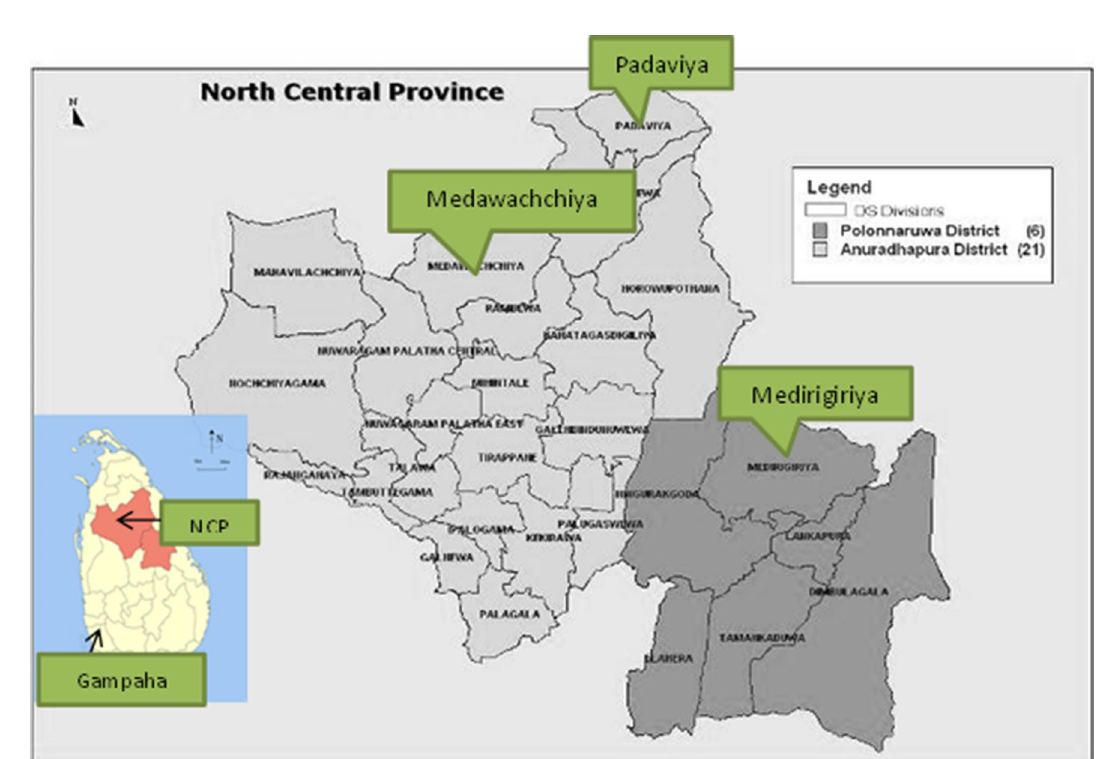
Fig. 2 Sample locations in Anuradhapura and Polonnaruwa districts and control area of Gampaha district